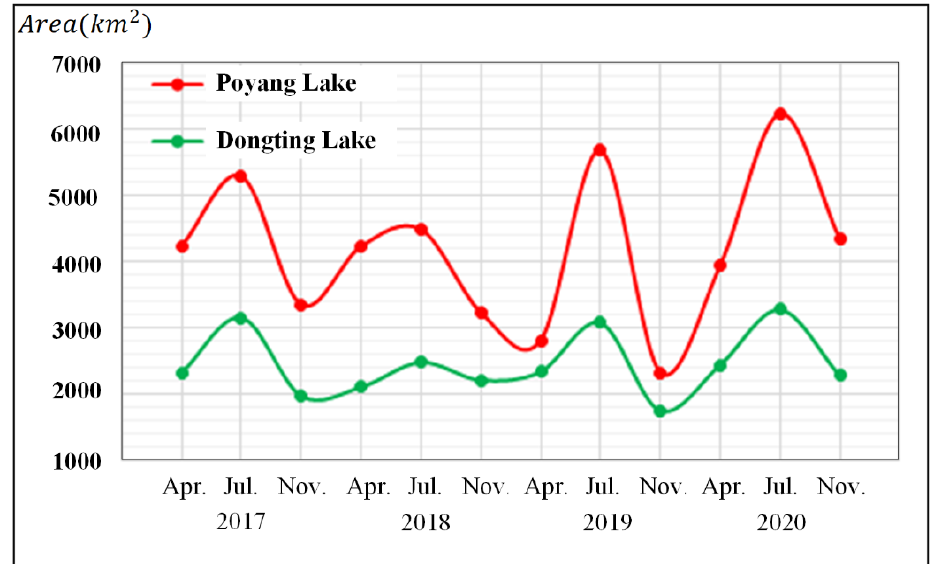
Figure 12. Temporal evolution of the water bodies surface in Dongting Lake and Poyang Lake.